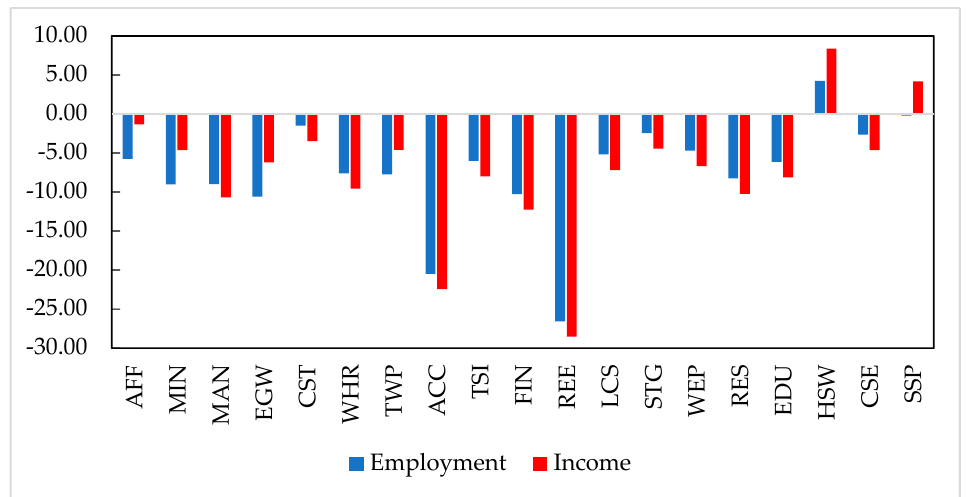
Figure 6. The impact of COVID-19 pandemic on labourer employment and earnings of sectors (%). Source: CHINAGEM model.